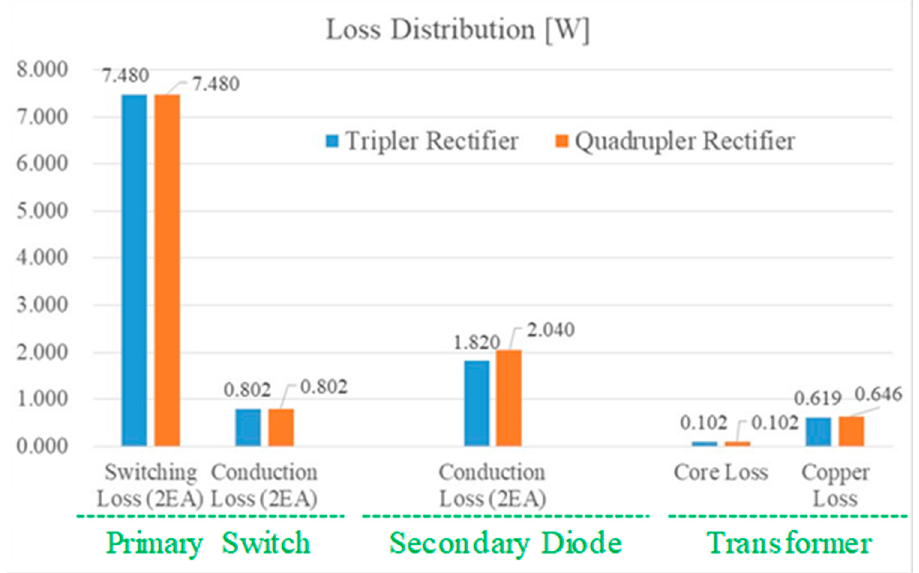
Figure 8. Loss distribution at full-load condition in voltage tripler and quadrupler.